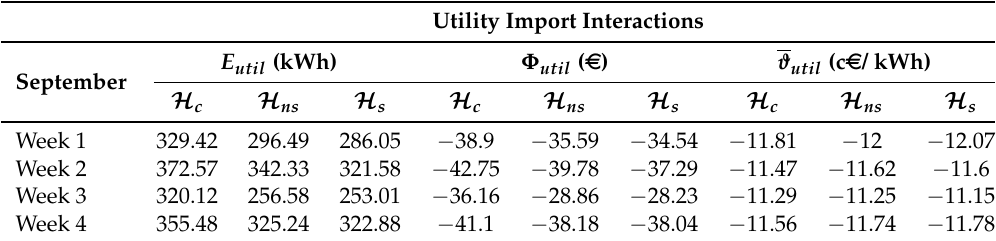
Table 3. Summary of energy interactions with the utility (purchased energy).